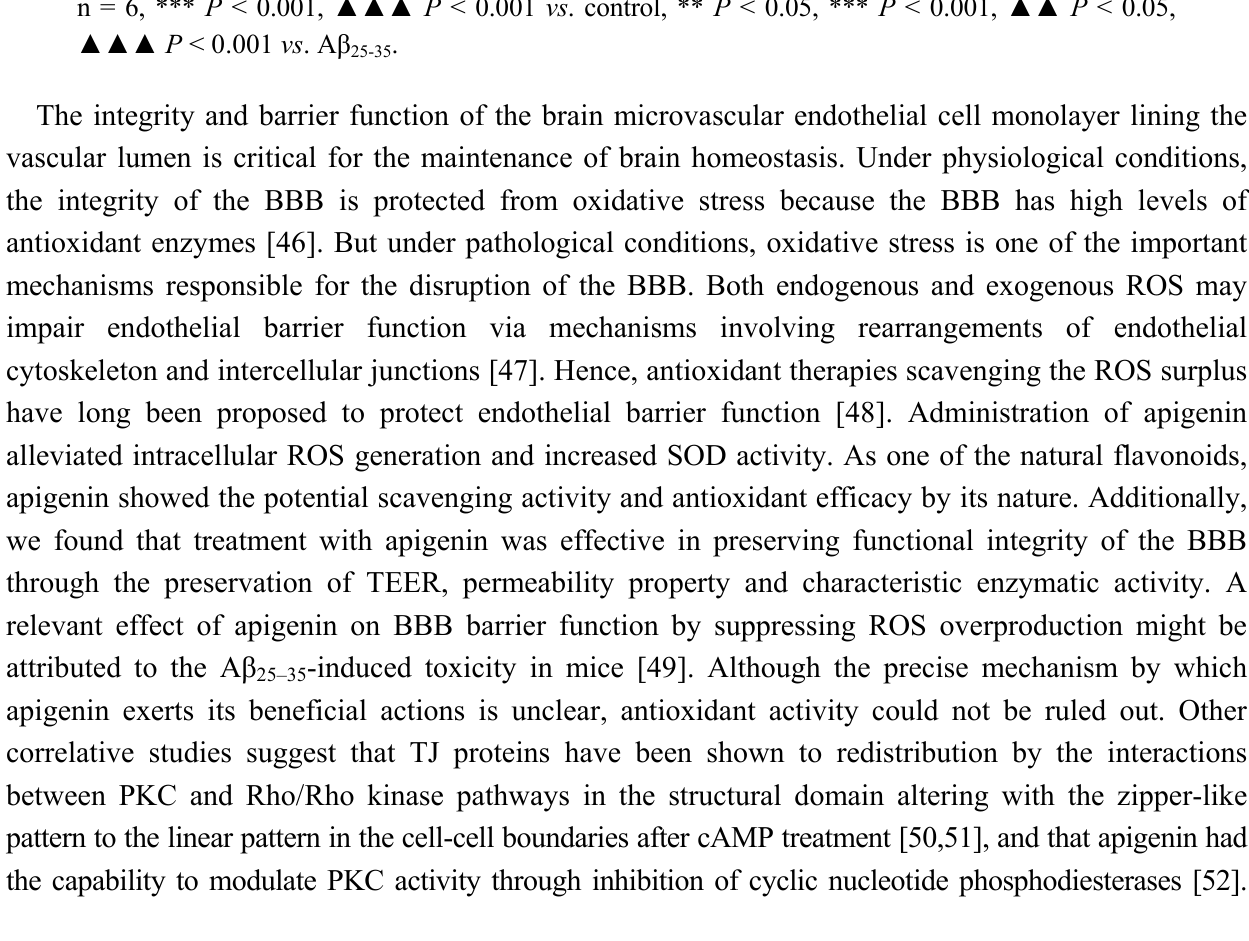
n = 6, *** P < 0.001, ▲▲▲ P < 0.001 vs . control, ** P < 0.05, *** P < 0.001, ▲▲ P < 0.05, ▲▲▲ P < 0.001 vs . A β 25-35